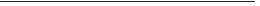
Frontiers in Psychology |